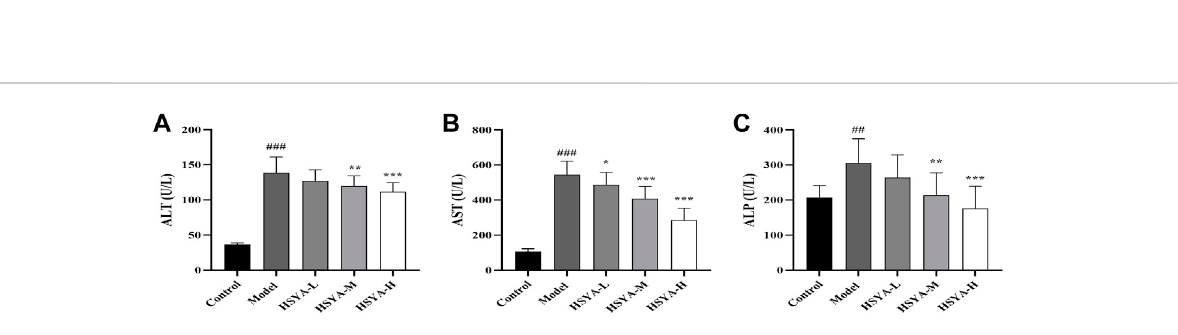
FIGURE 3 EffectsofHSYAonBiochemicalIndicators. (A) ALT; (B) AST; (C) ALP( (cid:1) x ± s , n =10). ### p < 0.001vs.thecontrolgroup;* p < 0.05,** p < 0.01,*** p < 0.001 vs. the model